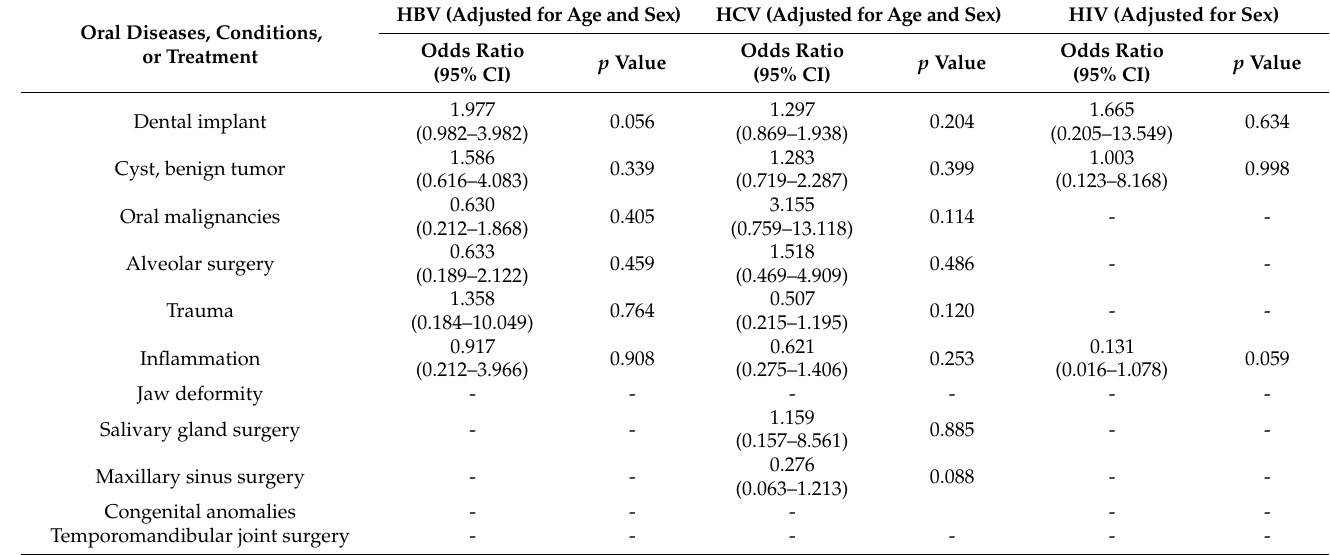
Table 7. A logistic regression analysis comparing the prevalence of infectious diseases in oral diseases, conditions, or treatments, with the prevalence of patients undergoing tooth